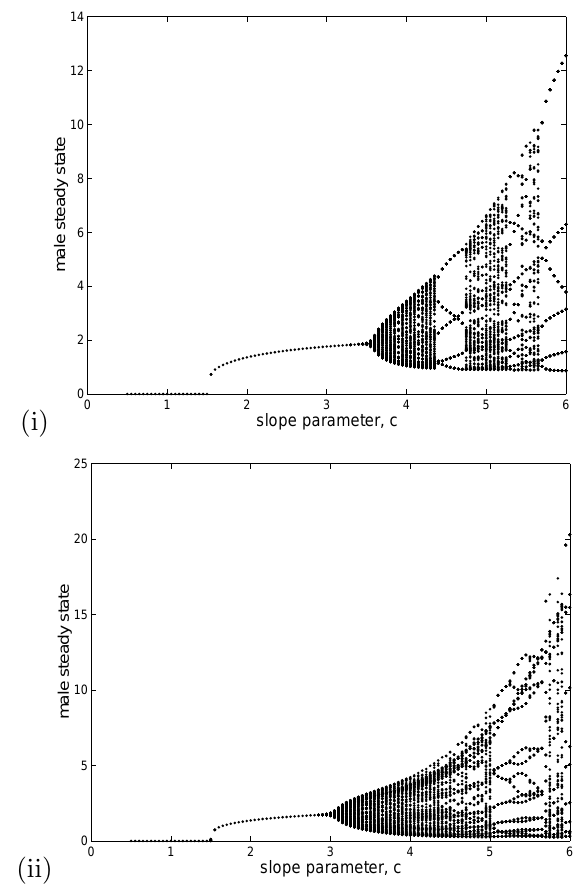
Figure 4: The dynamical solution at equilibrium of the two-sex model (3), using equations (5) and (6). Male stock against the parameter c , where θ = 0 . 5 , σ = 0 . 5 and (i) the delay factors are u = v = 1 . 0 , (ii) the delay factors are u = v = 3 . 0